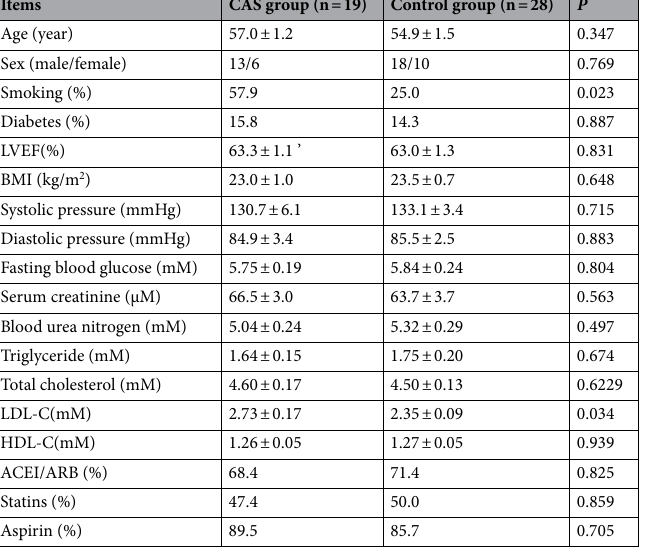
Table 1. Comparisons of general data between the two groups. CAS: coronary artery spasm; LVEF: left ventricular ejection fractio; BMI: body mass index; LDL-C: low density lipoprotein cholesterol; HDL-C: high density lipoprotein cholesterol; ACEI: angiotensin converting enzyme inhibitor; ARB: angiotensin receptor blocker.